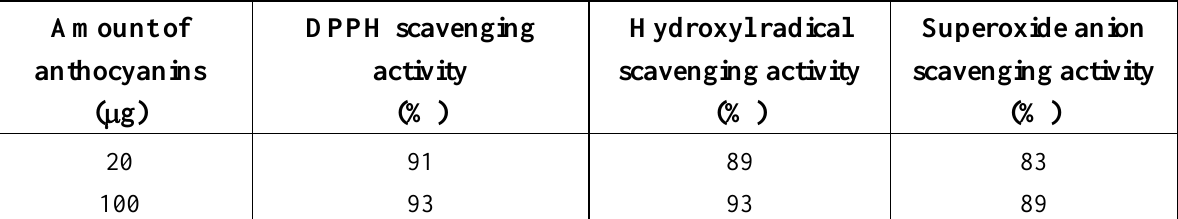
Table 3. Free radical scavenging activities (%) of anthocyanins extracted from pericarp tissues of litchi fruit at harvest